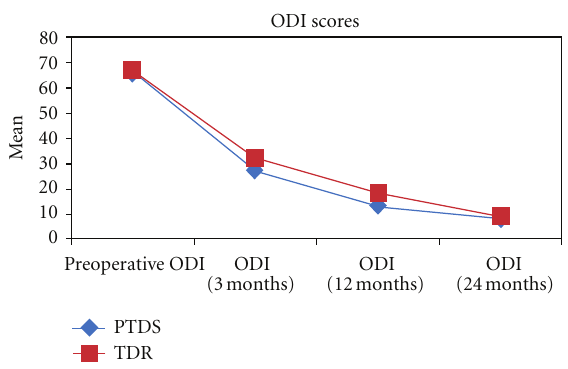
F 7: e distribution of ODI scores for both